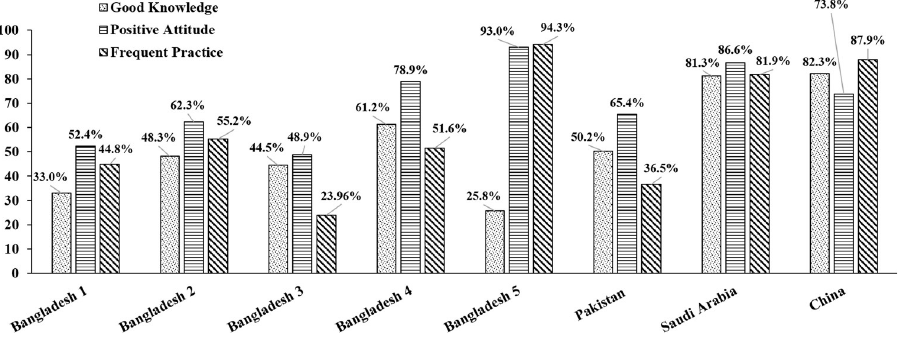
Fig 1. Diagram reflecting different countries and their peoples’ knowledge, attitude, and practice level toward covid-19. [Bangladesh 1 [4] , Bangladesh 2 [6] , Bangladesh 3 [8] , Bangladesh 4 [7] , Bangladesh 5 [5] , Pakistan [10]